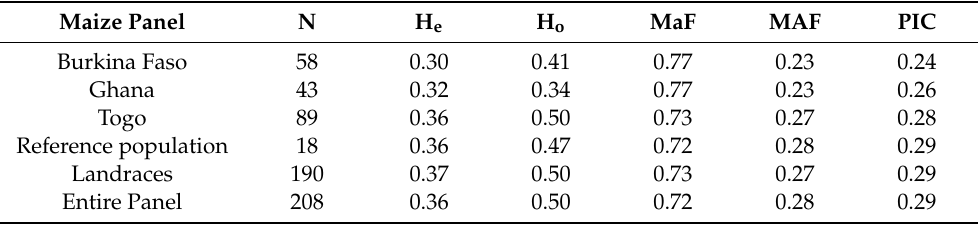
Table 1. Diversity statistics based on 5974 DArTseq markers across 208 maize accessions. Maize Panel N H e H o MaF MAF